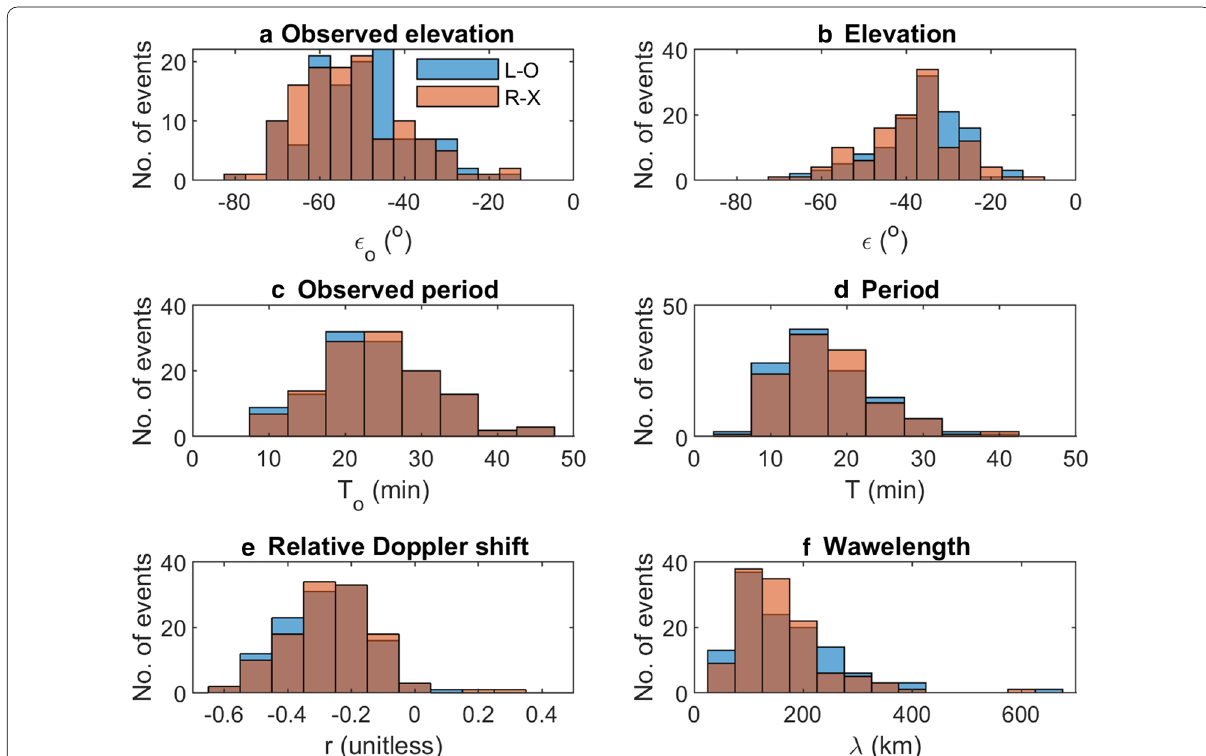
Fig. 8 Distribution of selected GW characteristics for the period July 2014–June 2015 (solar maximum) assuming L-O mode (blue) and R-X mode (orange) signals. a observed elevation